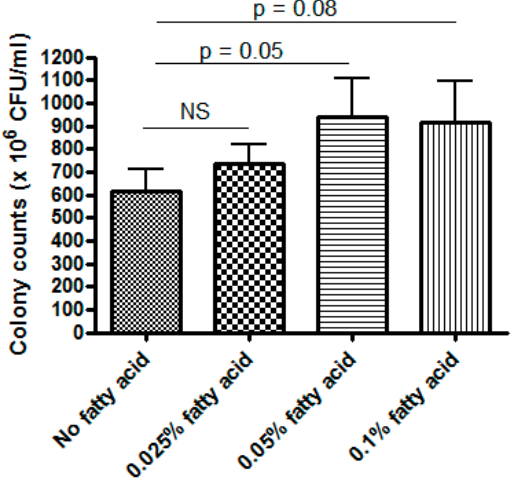
Table 2. Decreased lipids in HBM with LR in comparison to HBM without LR.